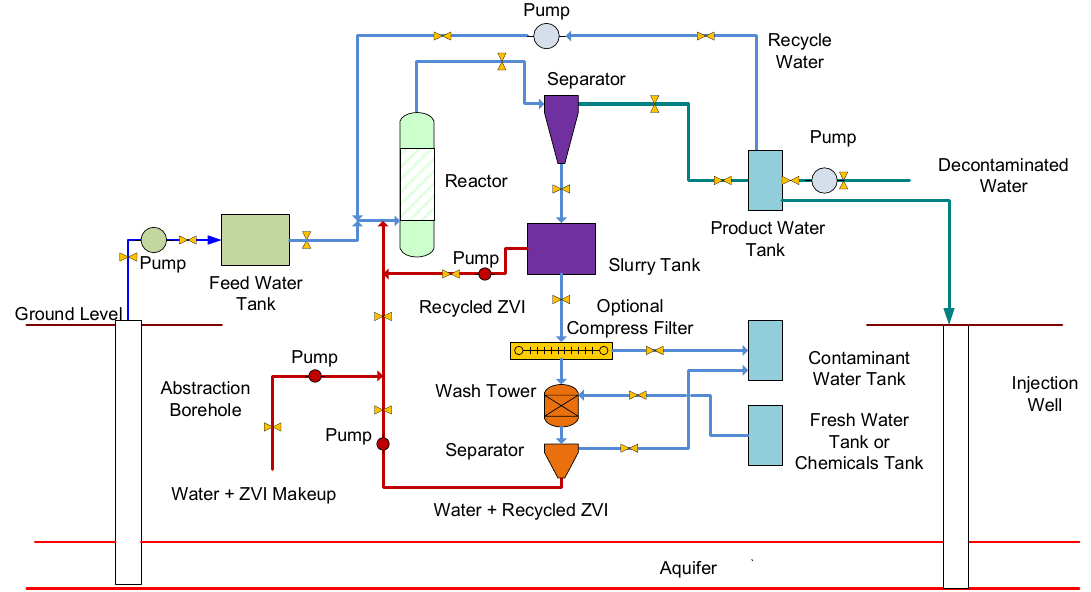
Figure A6. Process flow diagram for the decontamination of a confined aquifer, or unconfined aq- uifer.